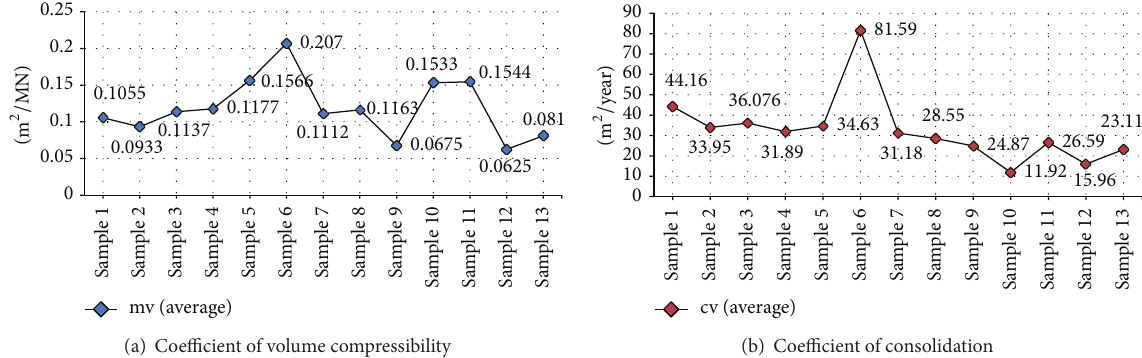
Figure 7: Distribution of coefficients in samples for consolidation test. (a) Coefficient of volume compressibility and (b) coefficient of consolidation.